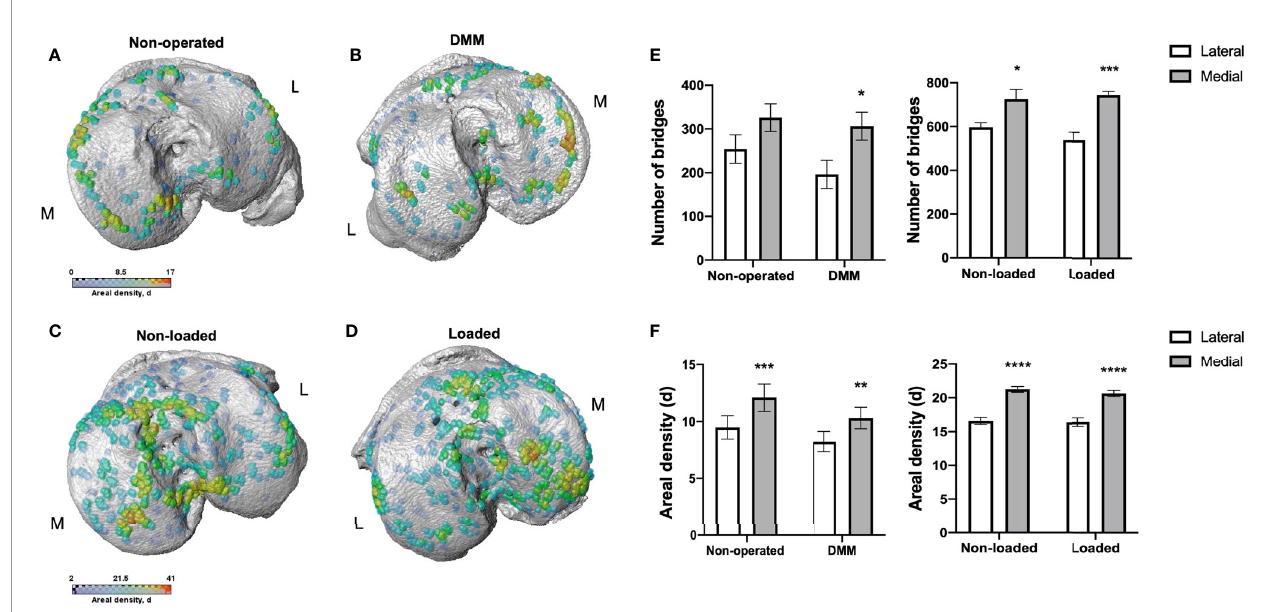
FIGURE 3 | Bridge location and bridge areal densities across the tibial growth plate of mice. Location and areal densities of bridges across the growth plate projected on the medial (M) and lateral (L) tibial joint surface in non-operated (A) , DMM (B) , non-loaded (C) and loaded (D) tibiae of mice at 16 and 18 weeks of age, number of bridges in lateral and medial tibiae of non-operated compared to DMM and non-loaded compared to loaded tibiae of mice (E) , Areal density (d) of bridges in medial compared to lateral tibiae, de fi ned as the number of bridges per 256 mm x 256 mm window of non-operated and DMM or non-loaded and loaded knee joints (F) . Bars represent mean ± SEM. Group sizes were n = 8 for non-operated and DMM-operated mice and n = 6 for non-loaded and loaded mice. * indicates differences between lateral and medial tibiae * p < 0.05 ** p < 0.01 *** p < 0.001 **** p <